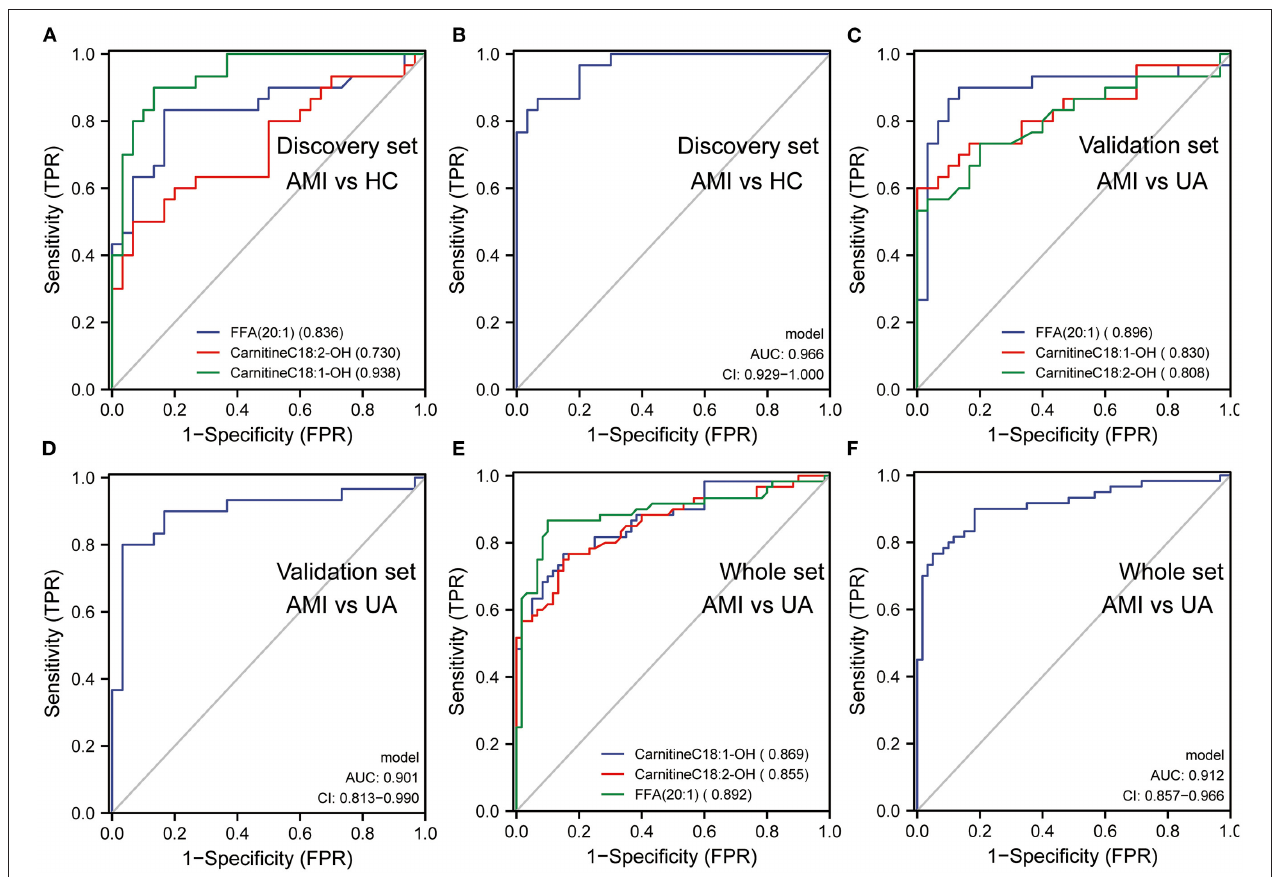
FIGURE 6 | The diagnostic efficacy of lipid biomarkers in AMI. (A) The diagnostic performance of lipid biomarkers in distinguishing AMI from HC was evaluated by ROC analysis in discovery set. (B) The diagnostic performance of diagnostic model in distinguishing AMI from HC was evaluated by ROC analysis in discovery set. (C) The diagnostic performance of lipid biomarkers in distinguishing AMI from UA was evaluated by ROC analysis in validation set. (D) The diagnostic performance of diagnostic model in distinguishing AMI from UA was evaluated by ROC analysis in validation set. (E) The diagnostic performance of lipid biomarkers in distinguishing AMI from UA was evaluated by ROC analysis in whole set. (F) The diagnostic performance of diagnostic model in distinguishing AMI from UA was evaluated by ROC analysis in whole set.